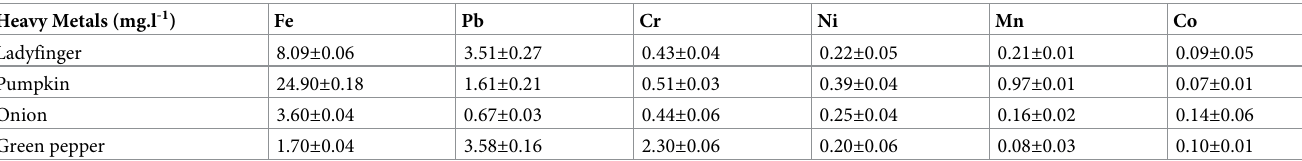
Table 4. Concentrations of heavy metals in vegetables irrigated with IWW. Heavy Metals (mg.l -1